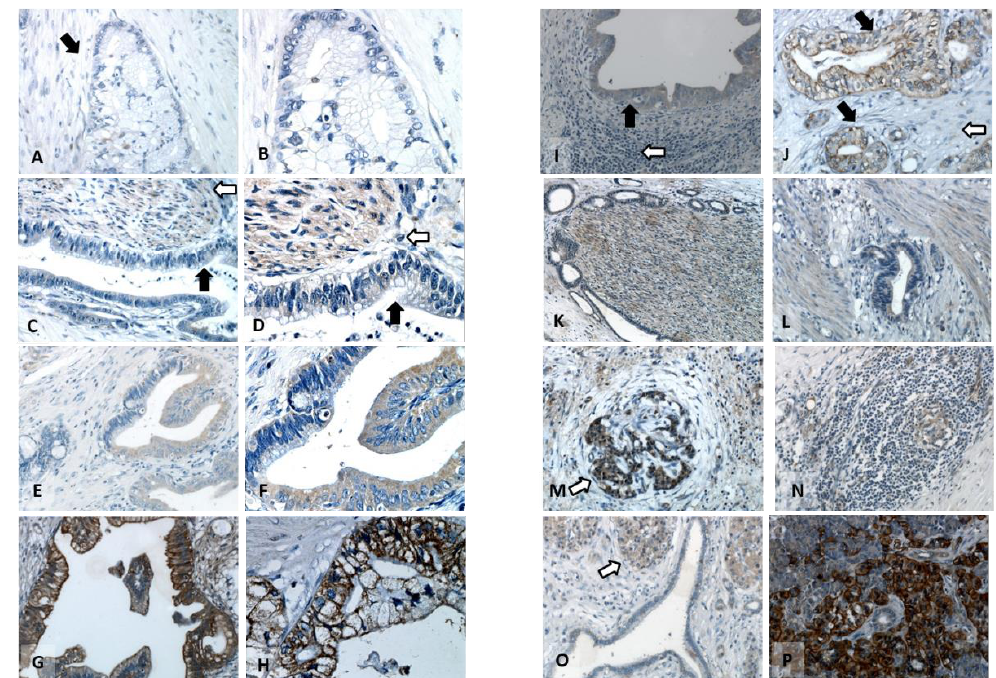
Figure 2. Epithelial and stromal PDAC cells express CXCR7 . Representative expression in PDAC (left panel 200x and 400x magnification): CXCR7-negative sample (black arrow) ( A , B ). CXCR7 low expression, with cytoplasmic staining with low diffusion (black arrow) ( C , D ), adjacent to CXCR7- positive nerves (white arrow). CXCR7 moderate expression, featured by heterogeneous mild diffusion, cytoplasmic CXCR7 staining ( E , F ). CXCR7 high expression, with diffuse and strong membrane and cytoplasmic staining ( G , H ). TME analysis (right panel): CXCR7-negative sample (white arrow), with positive PDAC (black arrow) ( I , J ). CXCR7 expression in nerves adjacent to PDAC perineural invasion (50 × magnification) ( K ) and in the fibrotic stroma ( L ) (200 × magnification). CXCR7 expression was reported in desmoplasia-trapped islets of Langerhans cells (white arrow) (200 × magnification) ( M ) in lympho-monocytic/endothelial infiltration ( N ) (200 × magnification) and in acinar cells belonging to the exocrine pancreas (white arrow) ( O , P ) (200 × and 400 ×